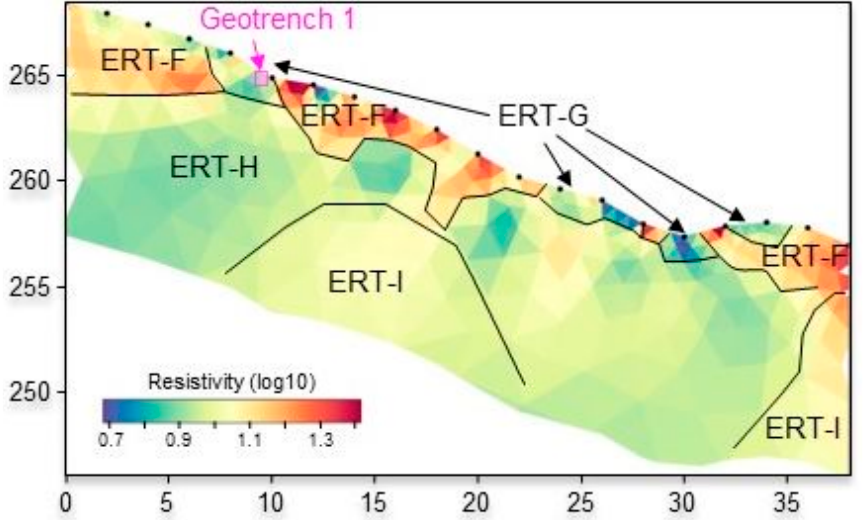
Figure 5. Electrical Resistivity Tomography (ERT) profile ERT-12 from the Lojanik 1 Valley, for the precise location of this transept see Figure 1c. The image displays the jointed inversion of resistivity measurements acquired with dipole–dipole, Wenner, and Schlumberger arrays.